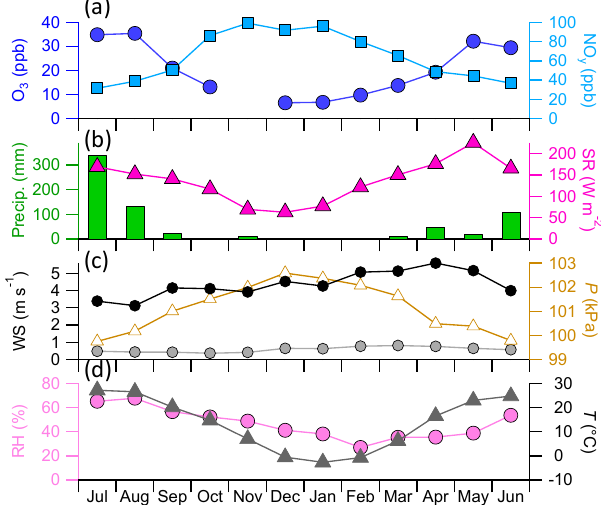
Figure 2. Monthly variation of (a) gaseous O 3 and NO y , (b) pre- cipitation (Precip.) and solar radiation (SR), (c) wind speed (WS) and pressure ( P) , and (d) relative humidity (RH) and temperature ( T ) . The WS at the heights of 8m (solid gray circles) and 240m (solid black circles) are shown in (c)